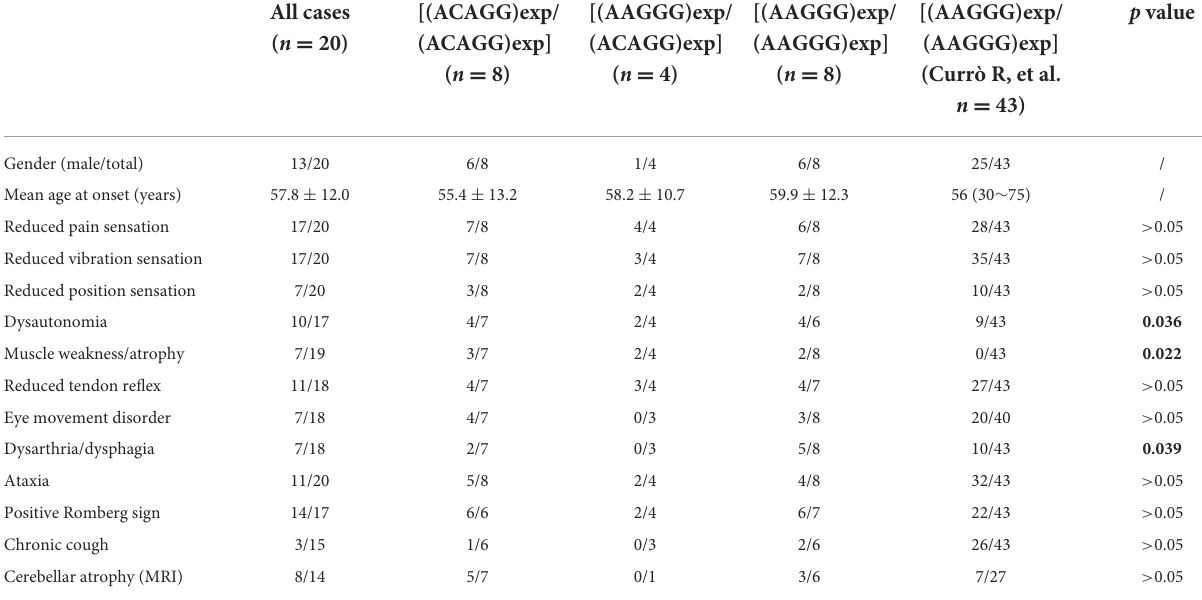
TABLE 2 Clinical features of 20 cases with multi-type disease-associated RFC1 repeat expansions.